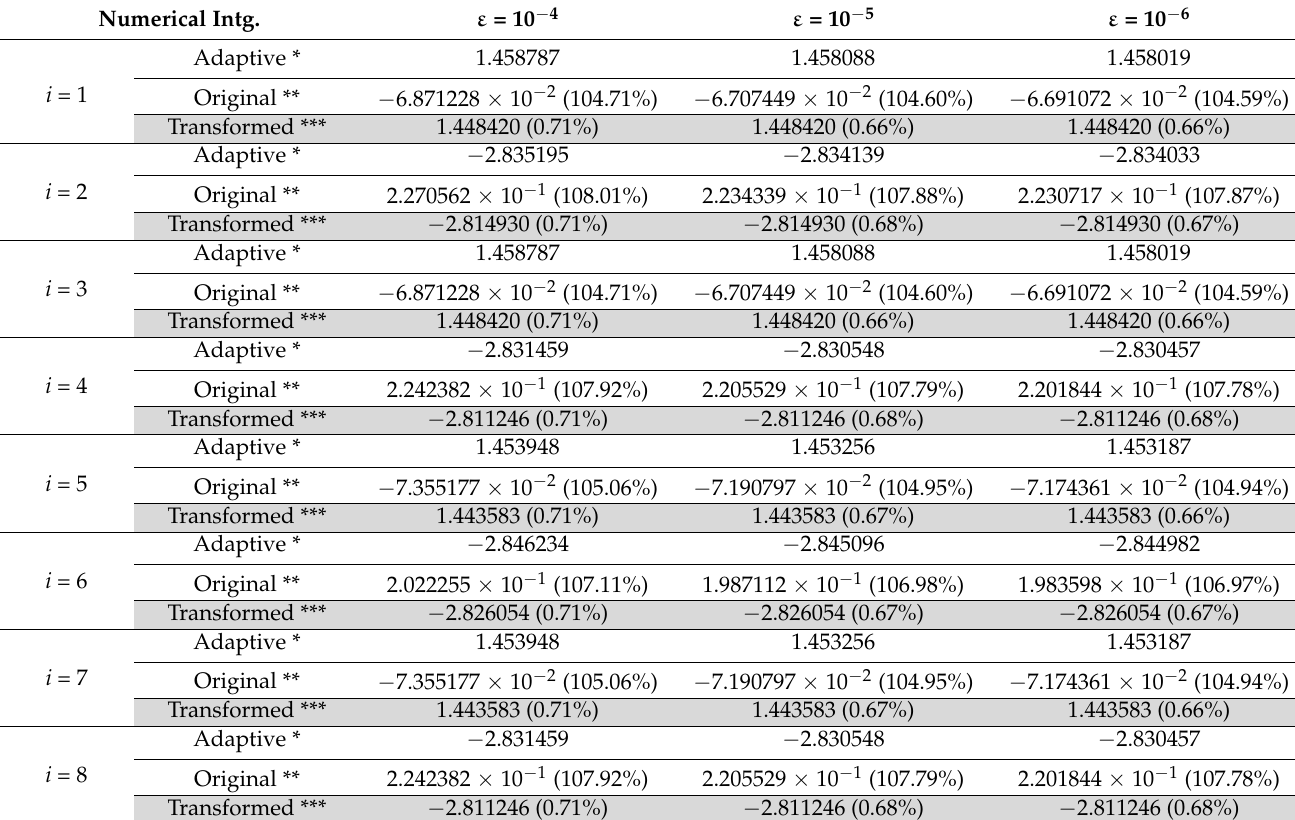
Table 2. Comparison of K i for the test problem when ε = 10 − 4 ~10 − 6 . Numerical Intg.